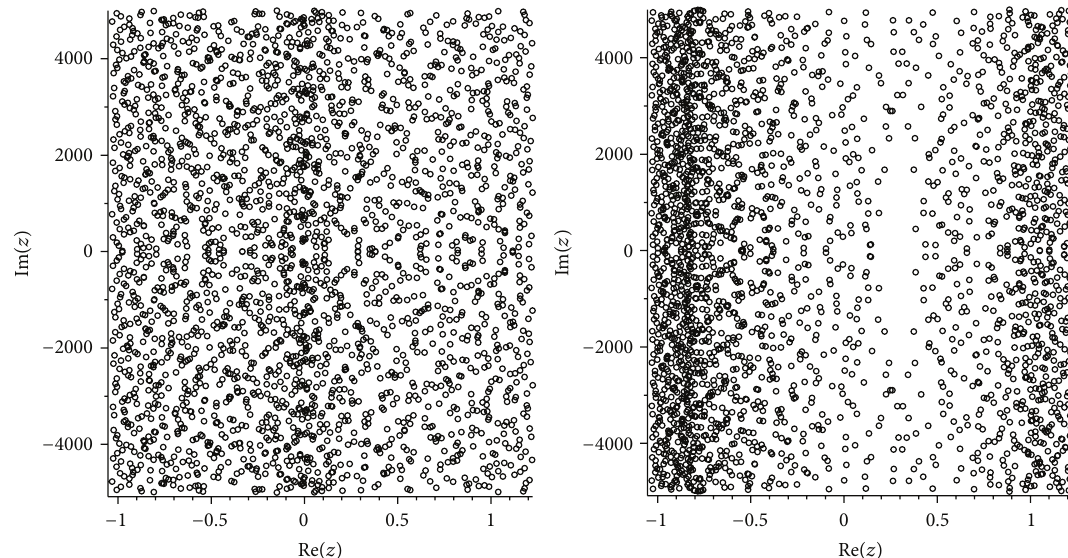
Figure 2: Zeros of the functions 𝑃(𝑧) and 𝑄(𝑧) of Example